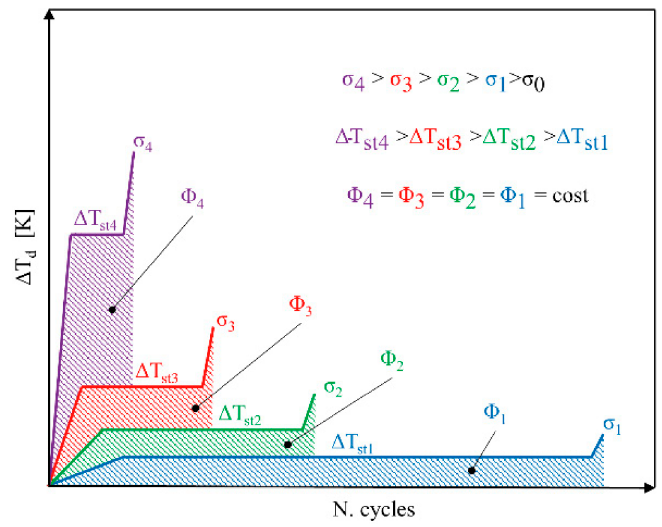
Figure 22. A schematic representation of temperature–cycle ( T − N ) curves under different applied stress levels, adapted with permission from Ref. [90]. Copyright © 2020 Elsevier